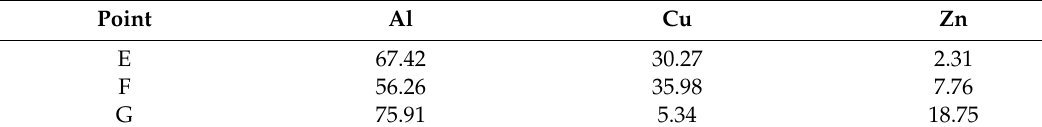
Figure 14. SEM image of brazing seam/Cu interfaces of 1035 Al/Cu joint brazed by Zn-15Al. Table 4. EDS results of chemical compositions (at. %) of points marked in Figure 14.